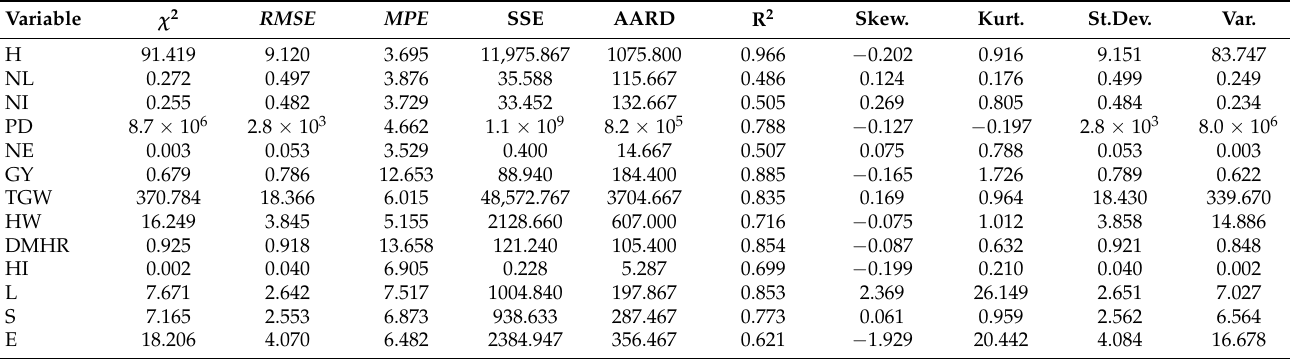
Table 4. The “goodness of fit” tests for the developed ANN